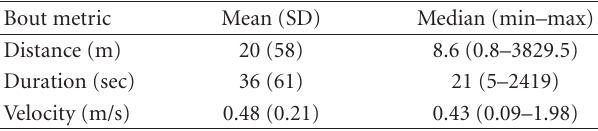
Table 3: Typical bout parameters. The minimum bout duration is 5 seconds by